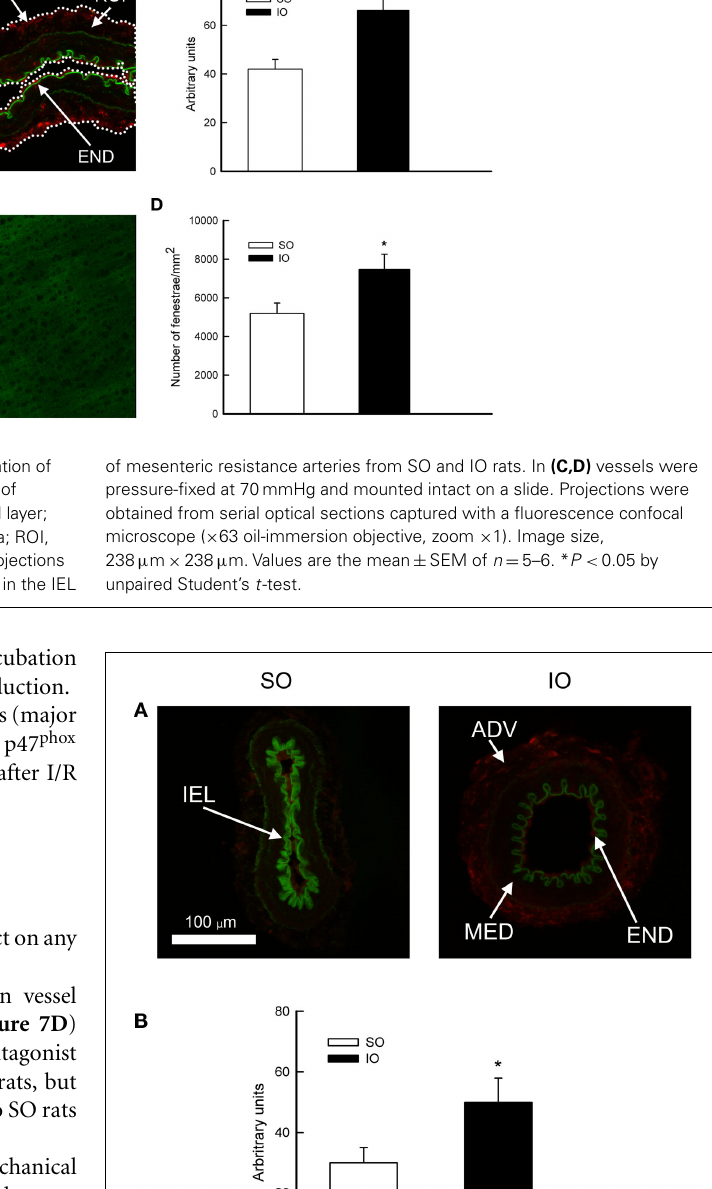
FIGURE 4 | (A) Representative photomicrographs and (B) quantification of ET-1 immunofluorescence of confocal microscopic sections of mesenteric resistance arteries from SO and IO rats. ADV, adventitial layer; END, endothelial layer; MED, media layer; IEL, internal elastic lamina. Image size, 238 μ m × 238 μ m.Values are the mean ± SEM of n = 6. * P < 0.05 by unpaired Student’s t -test.